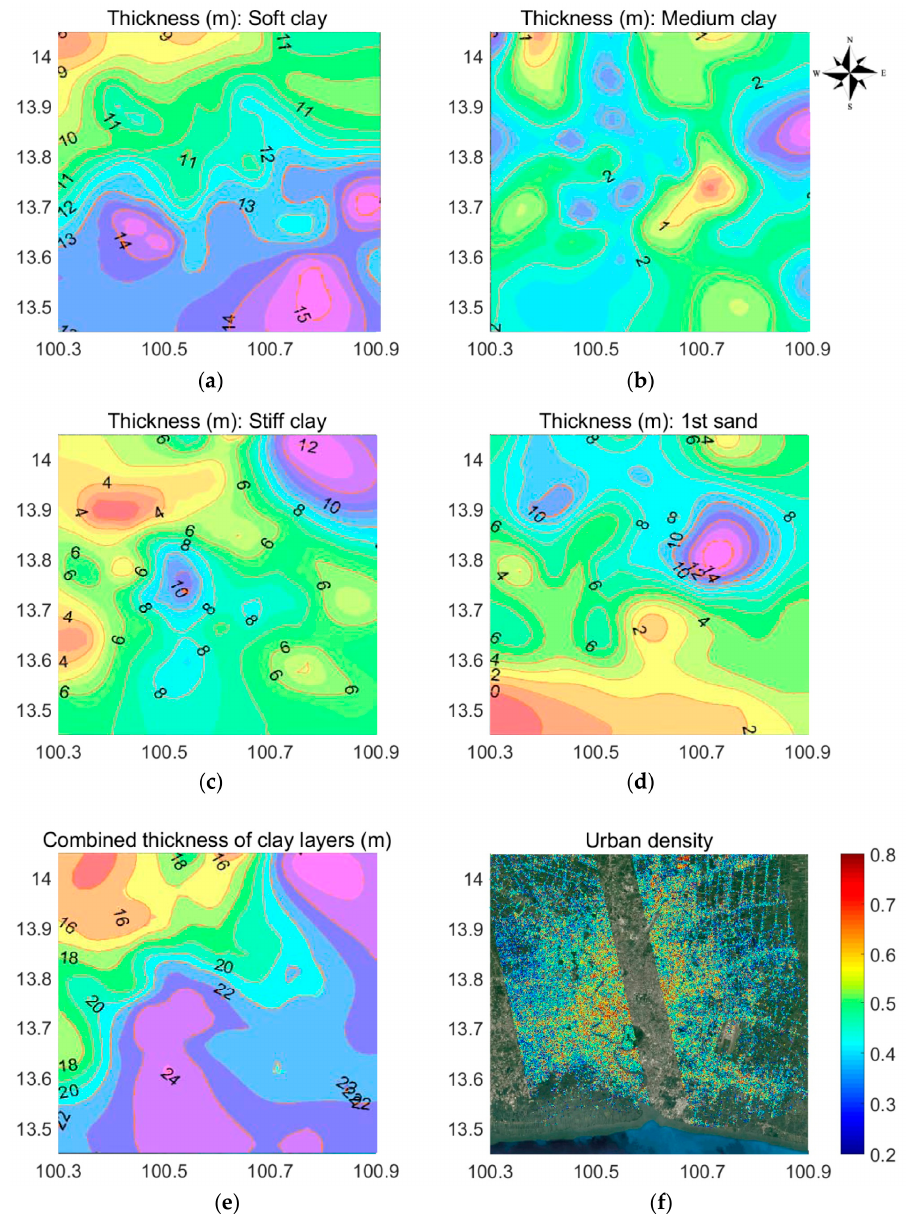
Figure 7. Geological strata and building density maps. ( a – d ) show the thicknesses of the soft clay, medium stiff clay, stiff clay and first sand layers, respectively; ( e ) the combined thickness of the top three clay (soft, medium and stiff) layers and ( f ) urban density. The background image used in ( f ) was provided by Google [30] and Copernicus.